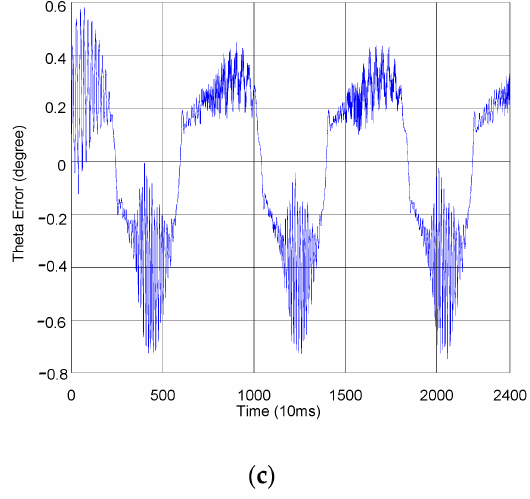
Figure 6. Results of the tracking circular trajectory of a robot arm (the θ 2 axis uses PID, and the θ 1 axis uses PID): ( a ) results of the tracking circular trajectory of a robot arm (the θ 2 axis uses PID, and the θ 1 axis uses PID); ( b ) tracking error of the θ 2 axis at a lower load; ( c ) tracking error of the θ 1 axis at a lower load;